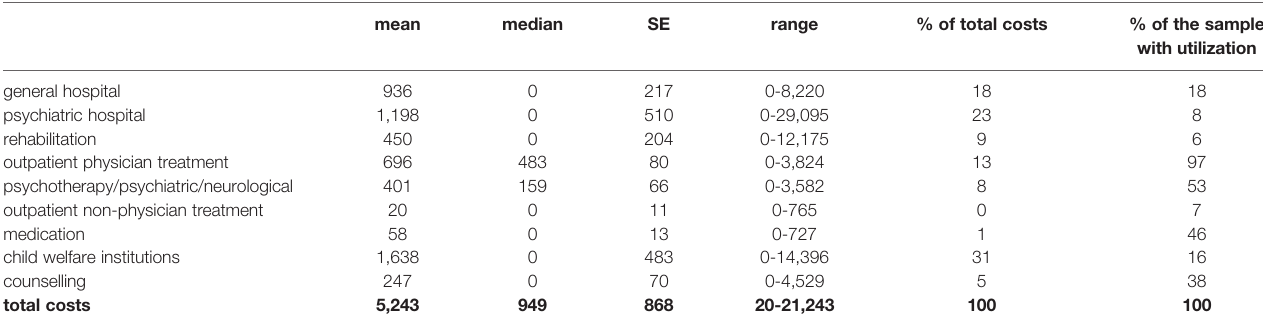
TABLE 2 | Six-month costs in 2014 Euros (n=87).